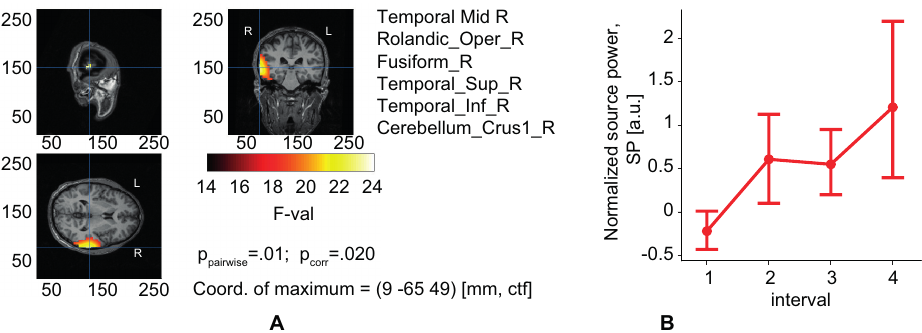
Figure 4. Results of the EEG data analysis in the source space: ( A ) Source plot shows F -value, reflecting the significant change of the source power (SP) between four intervals on the prestimulus interval t ∈ [ − 1.5,0 ] s, for f ∈ 8 − 12 Hz ( p = 0.02 via F -test, permutation-based correction). Legends contain p -values, CTF coordinates of the voxel with maximal F -value, and names of anatomical zones according to Automated Anatomical Labeling (AAL); ( B ) Normalized source power, NSP (group mean ± 95% CI) in this cluster on four